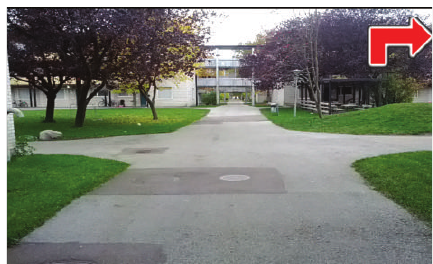
Figure 3: The participant’s view through a video see-through display, when the human operator pushes the turn right button.